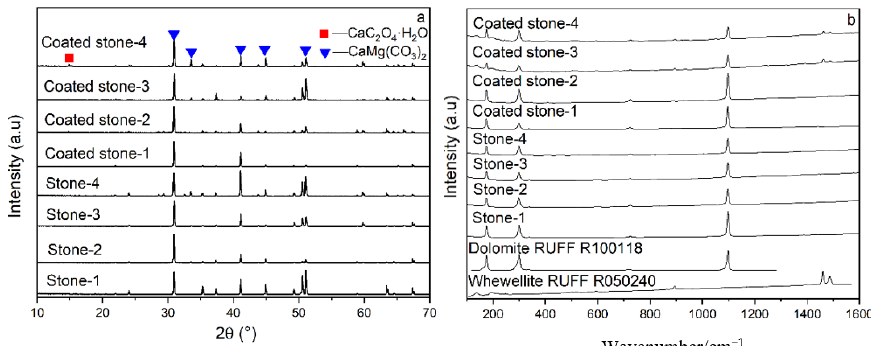
Figure 4. Composition of test samples after treatment with simulated acid rain at different pH values. ( a ) XRD, ( b ) Raman.